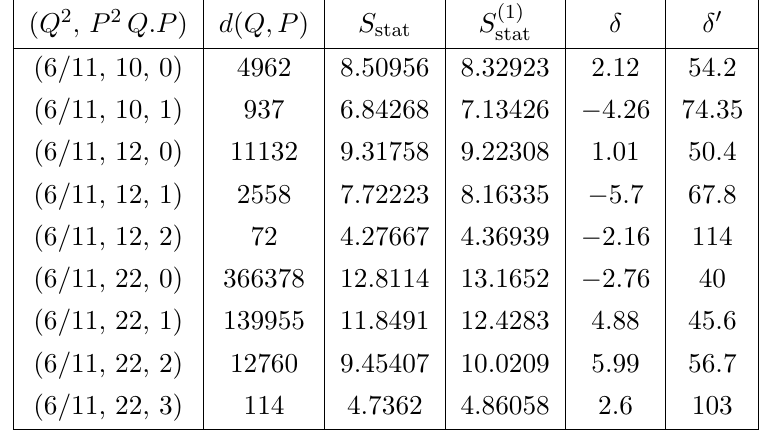
Table 9 . Comparison of the statistical entropy and statistical entropy at one loop for 11A orbifold.